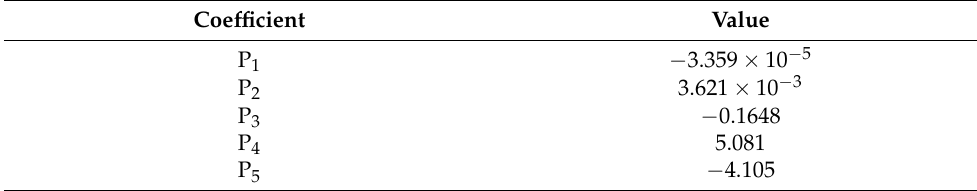
Table 4. Coefficients for estimating the manure coverage